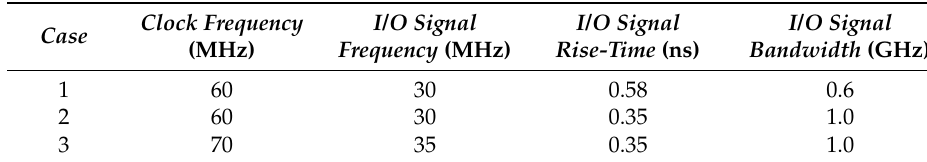
Table 2. Nominal operating conditions for the studied IC.